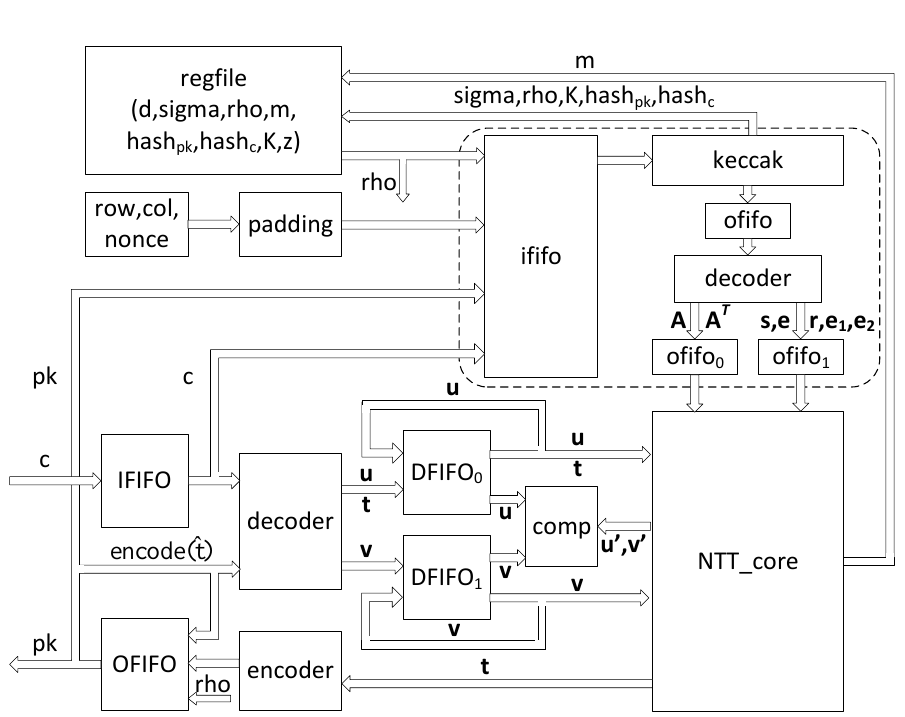
Figure 2: Data flow in server during the whole protocol. Symbols of intermediate values located above/to the left of data path arrows correspond to key generation and decryption phase, while values located below/to the right correspond to re-encryption